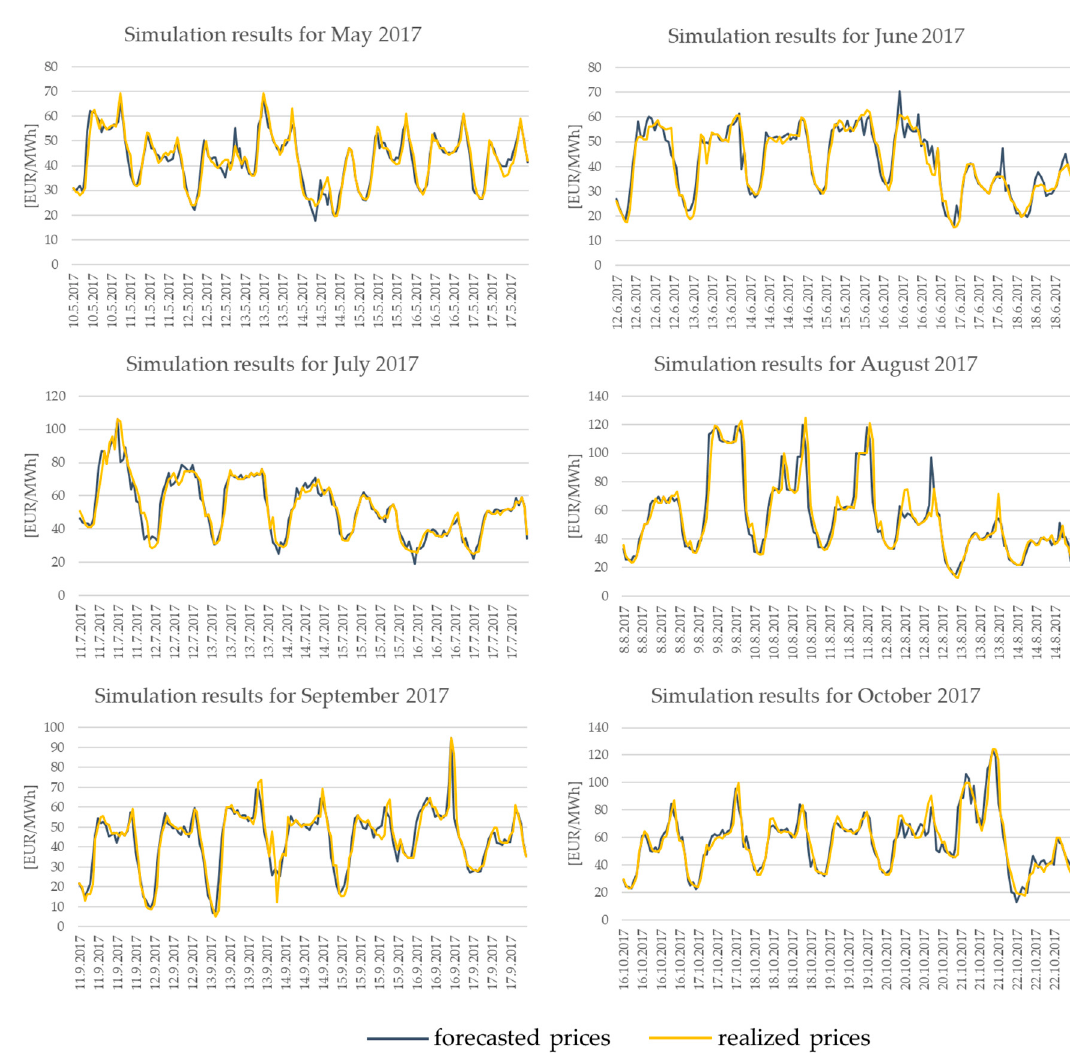
Figure 21. Forecasted and actually realized hourly prices in third forecasting interval for the period from May 2017 to October 2017.